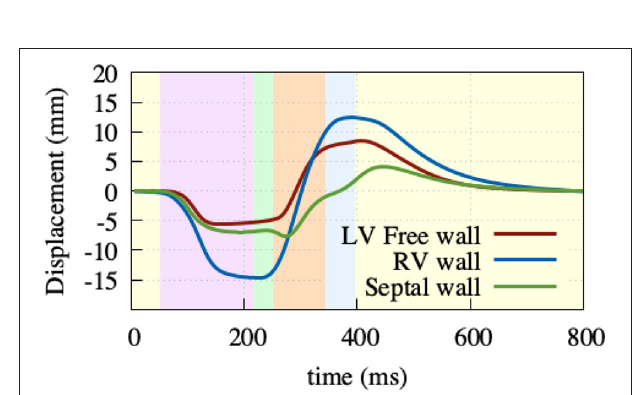
FIGURE 8 | Atrioventricular plane displacement. Extracted at the base of the right ventricular free wall (blue), base of the left ventricular free wall (green), and base of the septal wall (red), with positive displacement indicating a shift toward the apex. At the beginning of the heart cycle during atrial contraction (light-purple), the valve plane is pulled upward to then rapidly move downwards during ventricular contraction (light-green, light-orange), and then back to its initial state during the relaxation phase